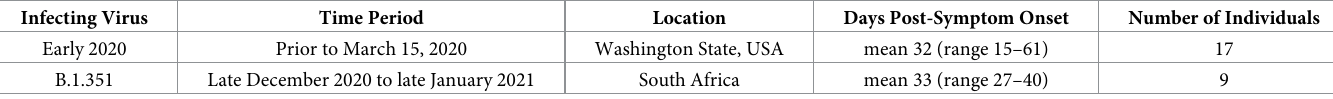
Table 1. Information on cohorts of individuals infected with early 2020 or B.1.351